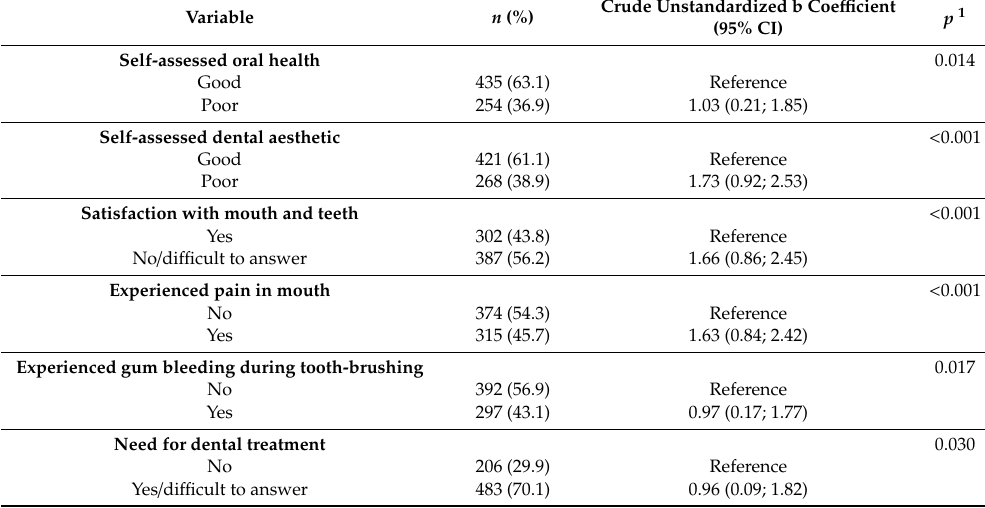
Table 3. Self-reported oral health characteristics associated with perceived stress in the study